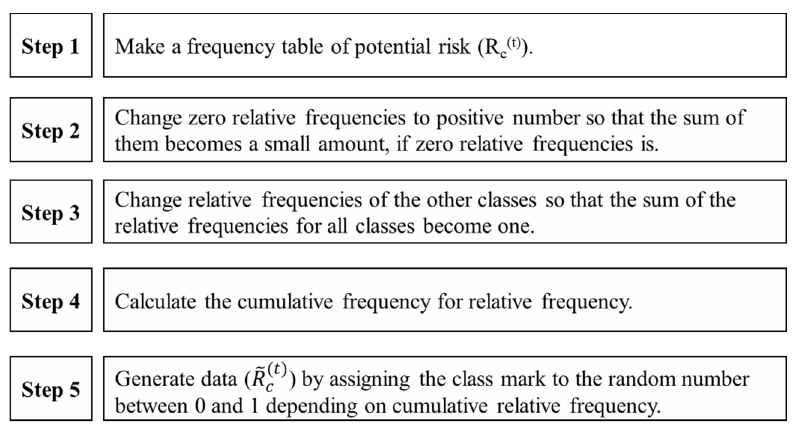
( t ) (cid:3030)((cid:3047)) ) using the potential risk 𝑅 c ) using the potential risk R